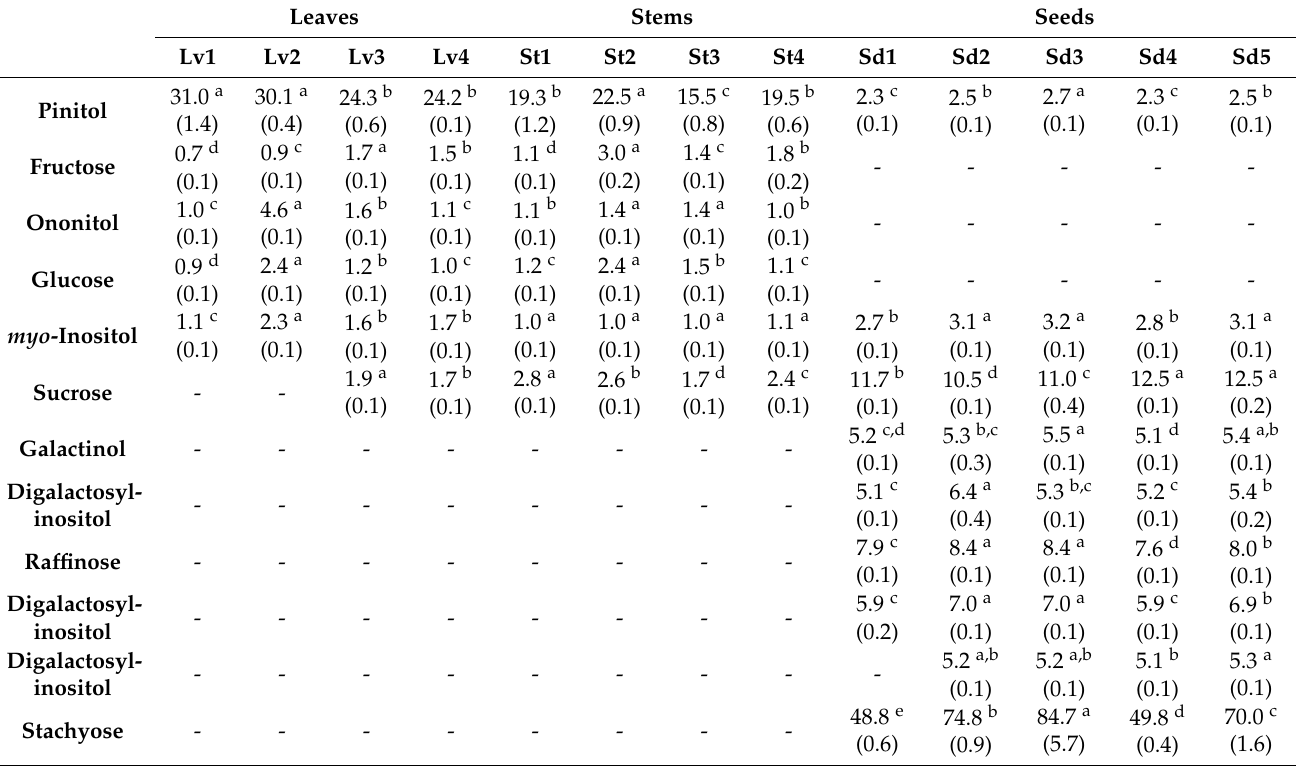
Table 3. Inositol, α -GOS and other low molecular weight carbohydrate content (mg · g − 1 ) of MAE leaves, stems and seeds alfalfa extracts. Standard deviation in brackets ( n =